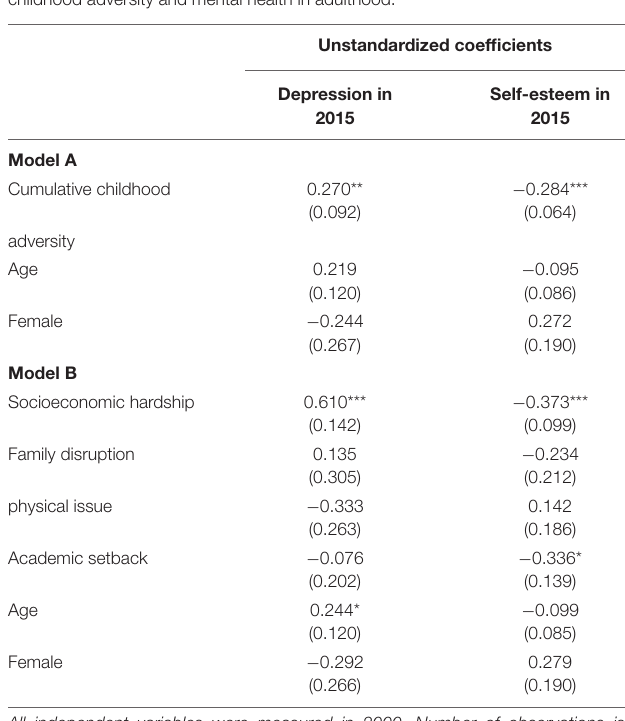
TABLE 4 | Maximum likelihood estimates of the associations between cumulative childhood adversity and mental health in